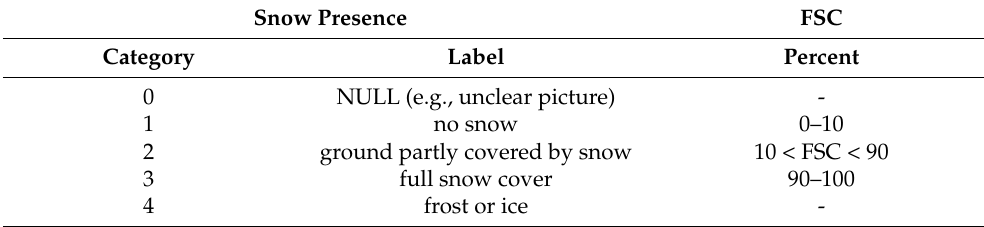
Table 1. Correspondence between visual inspection of snow scale and FSC limits. Snow Presence FSC Category Label